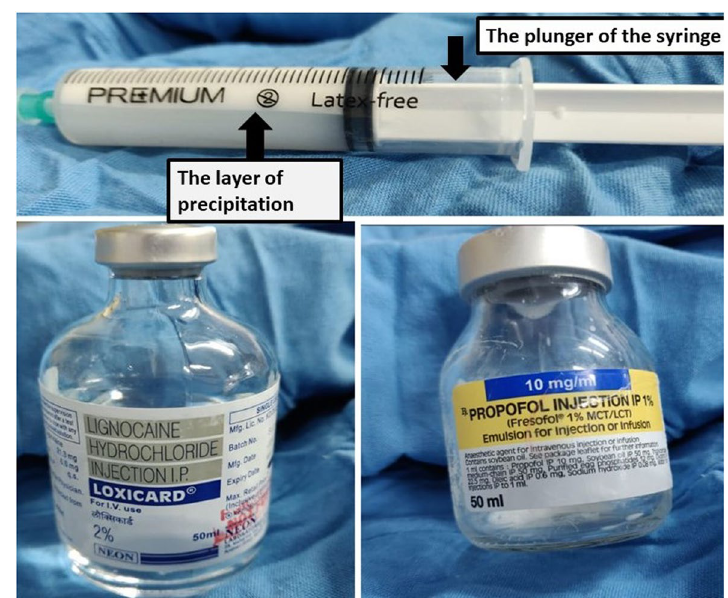
Fig. 1 Distinct layer of precipitation of propofol-lignocaine in a